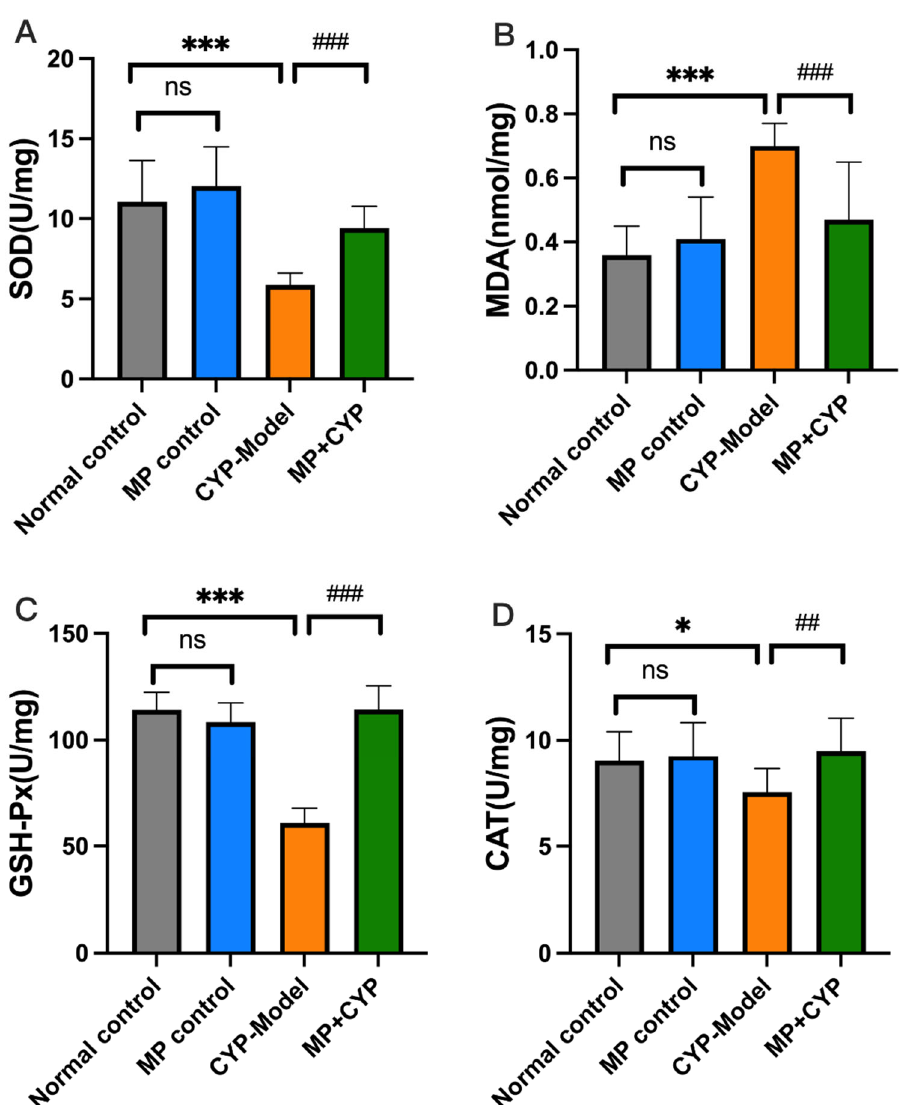
Figure 5. Effect of Maca polysaccharide on antioxidant enzymes in liver tissue of CYP-treated mice ( n = 12). ( A ) SOD; ( B ) MDA; ( C ) GSH-Px; ( D ) CAT. * p < 0.05, *** p < 0.0001 compared with Normal Control group; ## p < 0.01, ### p < 0.0001 compared with CYP Model group. Data are expressed as means ± SEM.